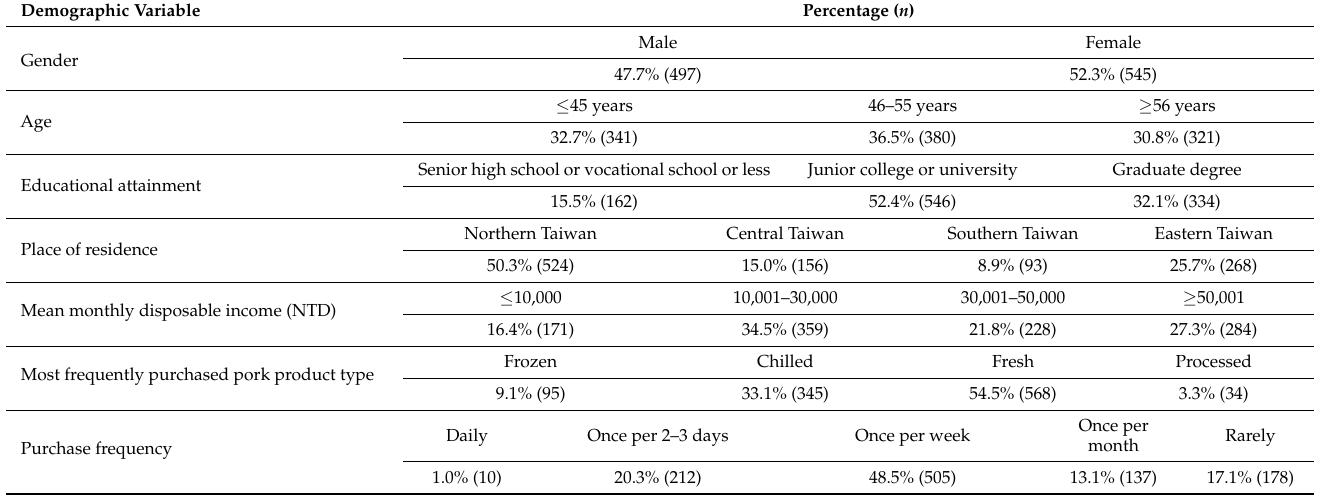
Table 1. Descriptive statistics of demographic variables ( n =